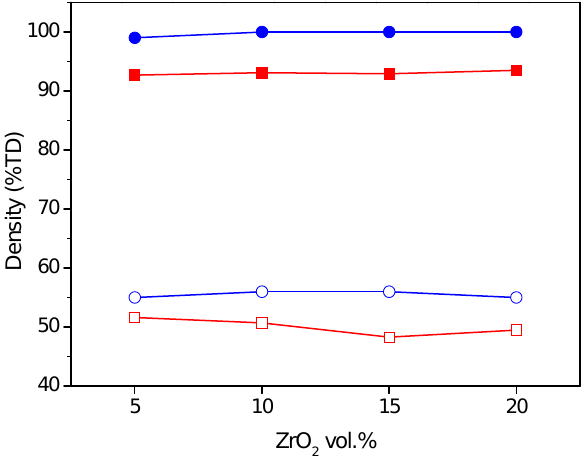
Figure 1. Green (empty symbols) and final (full symbols) density of alumina-zirconia (AZ) samples, obtained by uniaxial pressing (red) and slip casting (blue), as a function of the ZrO volume content. 2